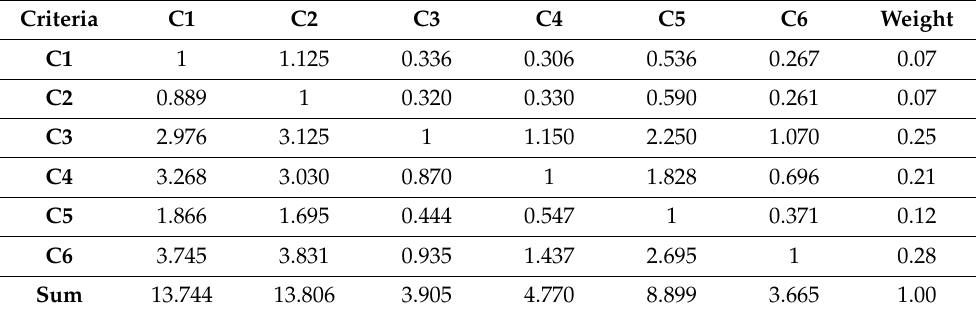
Table 9. Pairwise comparison matrix for commercial land use suitability using the geometric mean of the preferences with the computed weights.